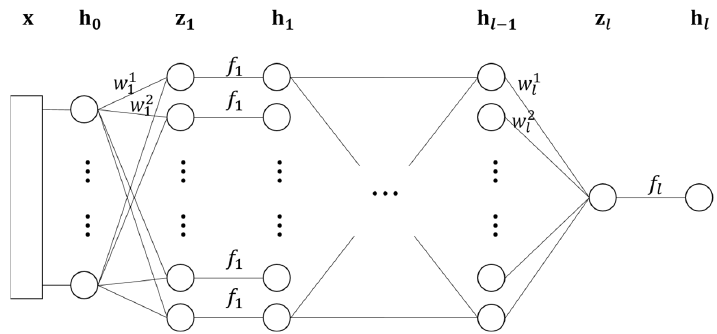
Figure 1. Multi ‐ layer neural network structure. Figure 1. Multi-layer neural network